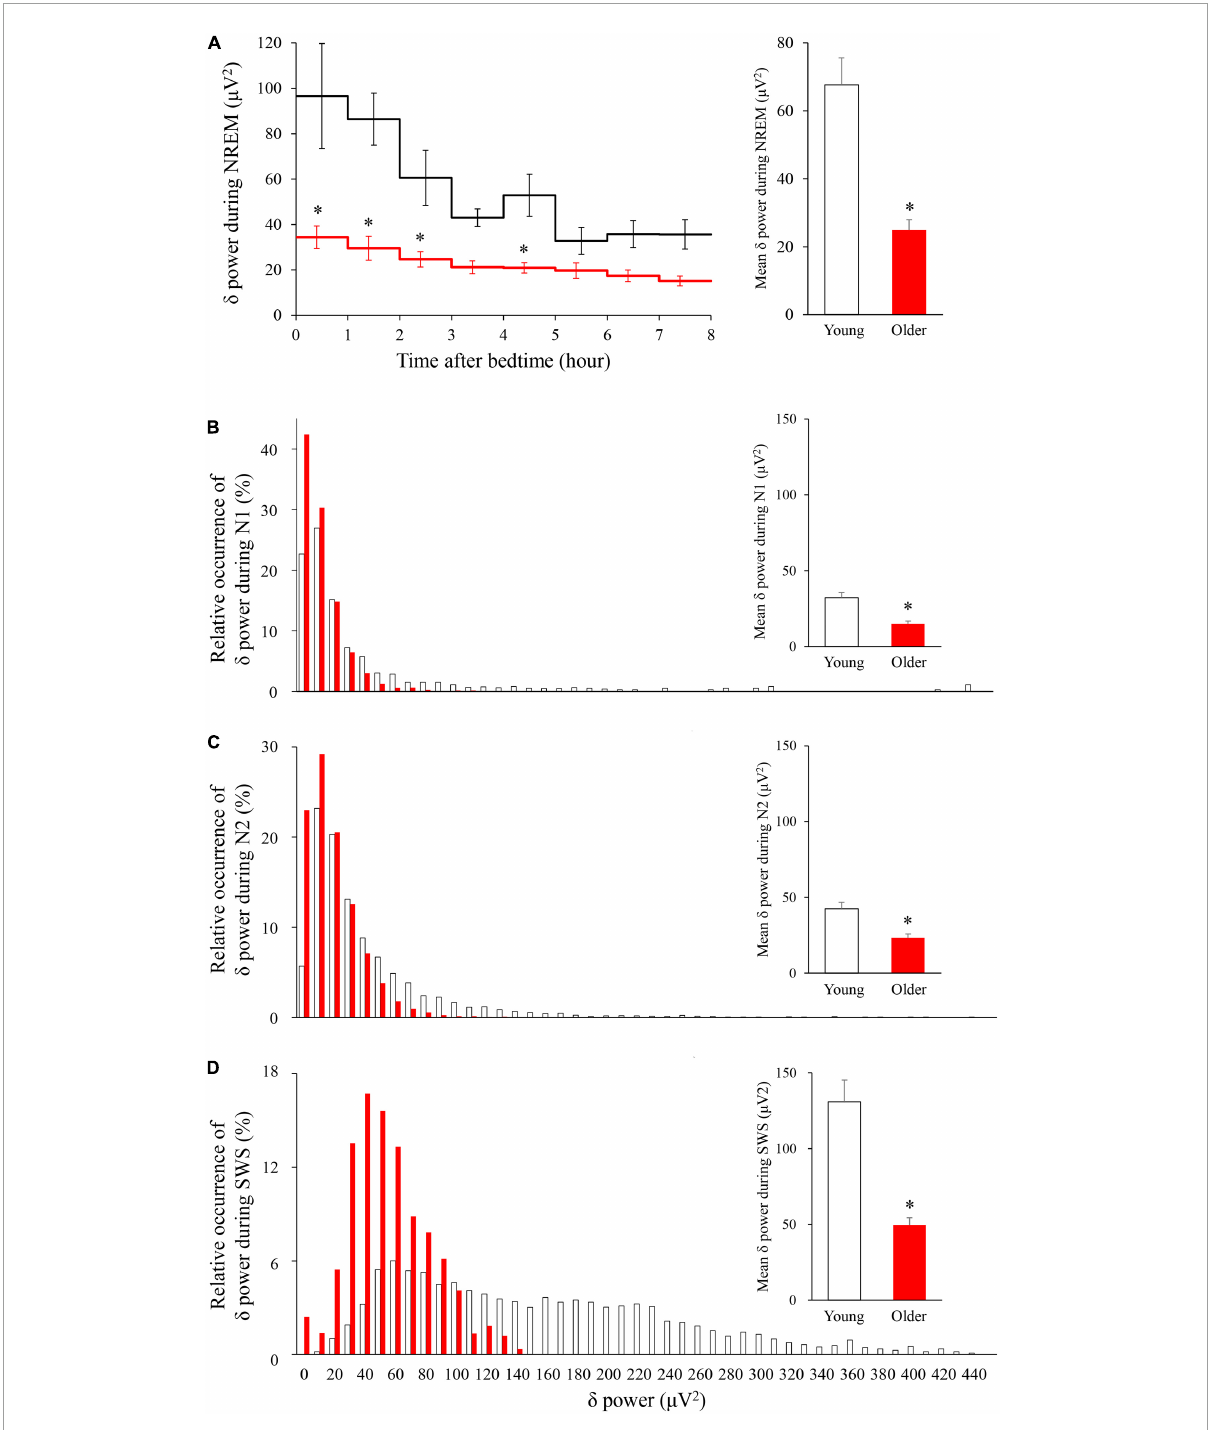
FIGURE4 Time course of delta power of NREM sleep EEG (A) and relative occurrence of delta power in each NREM stage (B–D) . (A) An hourly mean ± SE of delta power of the two groups is shown as a line graph and mean delta power during NREM is shown as a bar graph. Hourly mean ± SE is shown for young women (white) and older women (red). The main effect of age, main effect of time, and interaction p -values of two-way repeated measures ANOVA were all p < 0.001. Asterisks represent statistically significant difference between the two age groups by post-hoc pair-wise comparisons using the Bonferroni’s correction ( p < 0.05). Relative occurrence distribution of 5-s delta power and mean delta power during N1 (B) , N2 (C) , and SWS (D) . Asterisk represents a statistically significant difference between the older and young subjects by an independent t -test ( p < 0.05), and error bars denote the standard